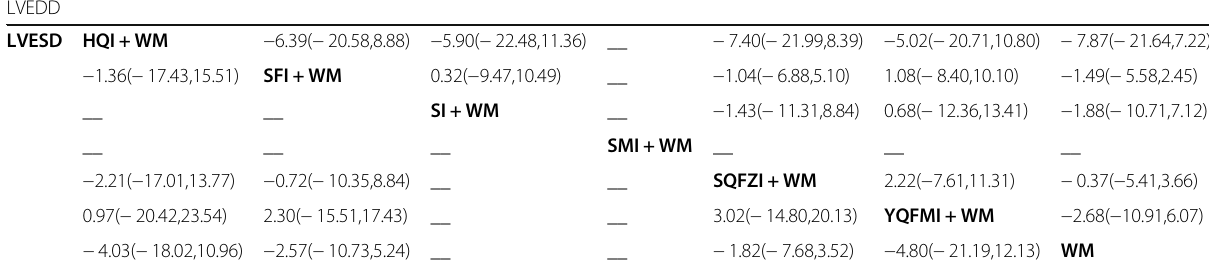
Table 4 Mean difference (95%CIs) of LVEDD (right upper part) and LVESD (left lower part) LVEDD